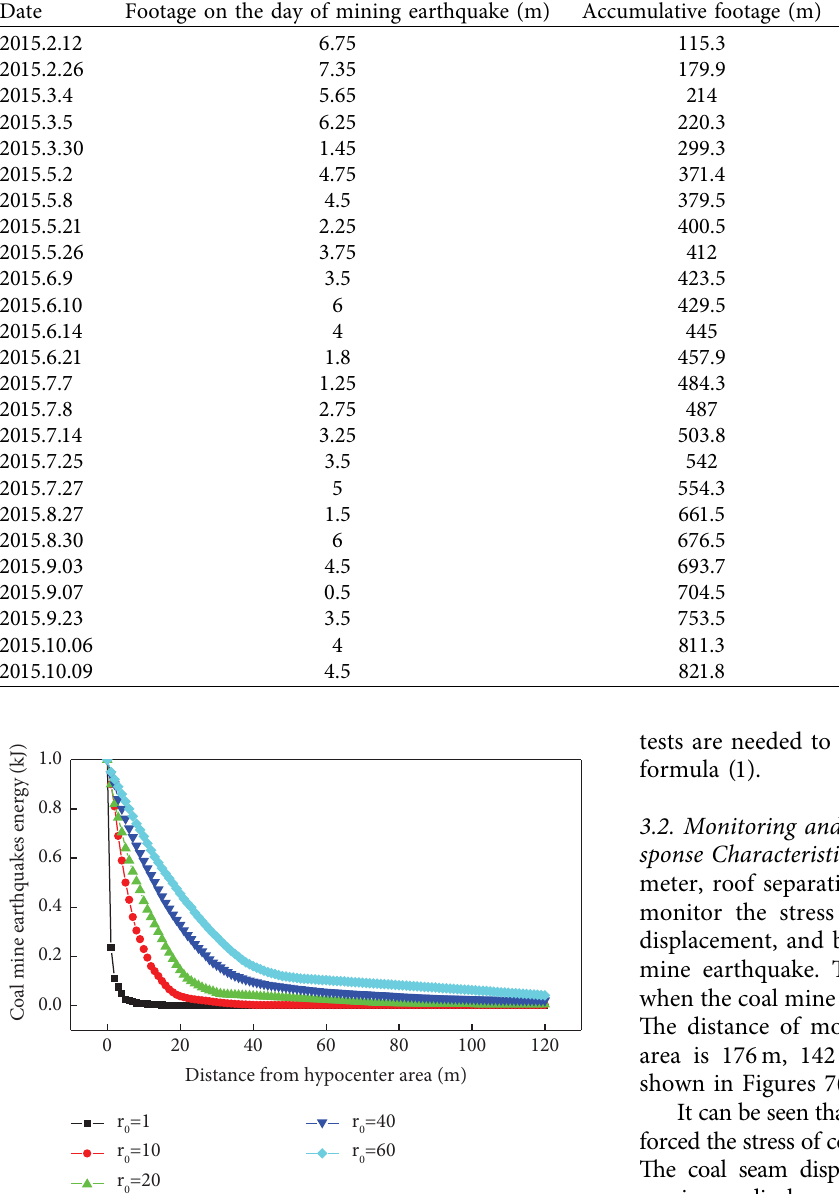
Figure 6: Dissipation characteristics of coal mine earthquakes energy